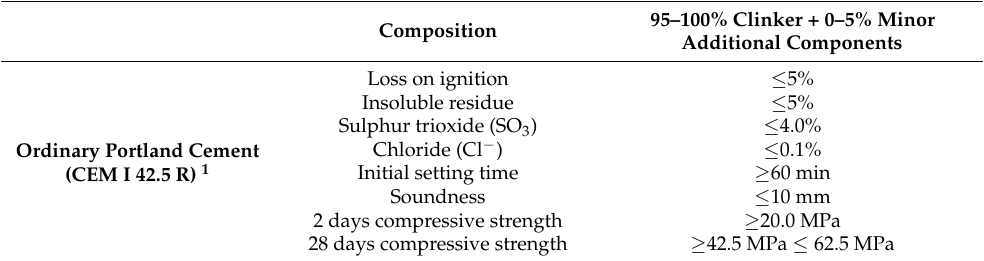
Table 1. Composition and properties of cement used in the present